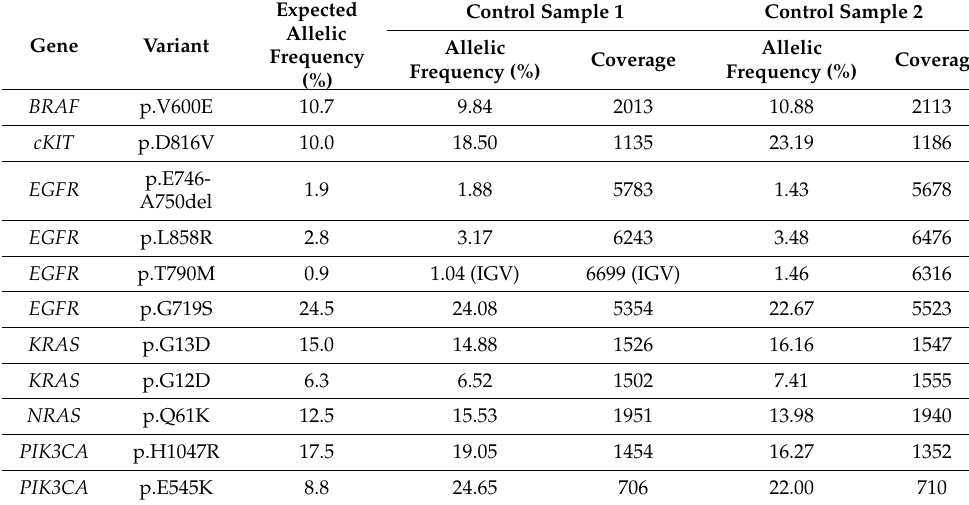
Table 2. Results of the two control samples. The EGFR p.T790M mutation in control sample 1 was only observed in the bam file by the